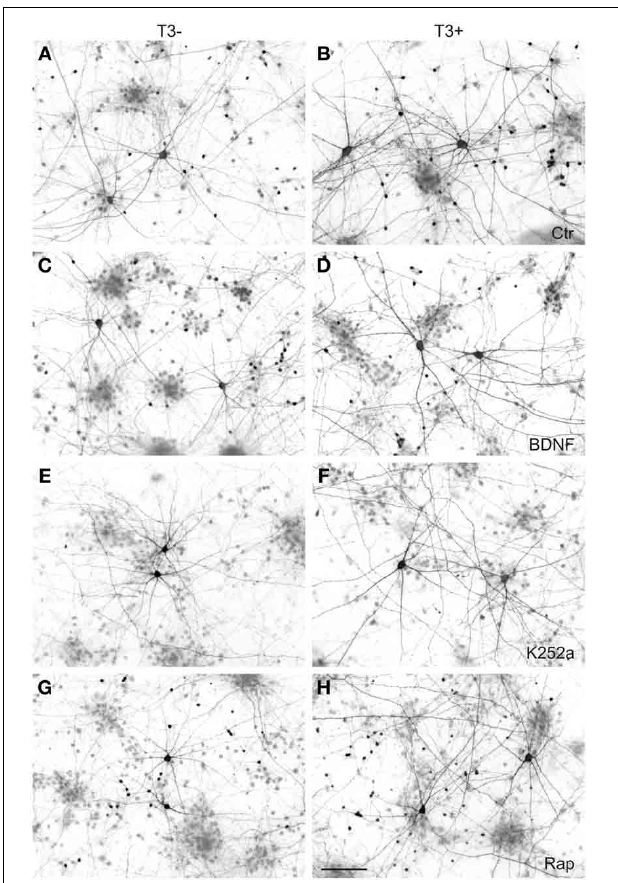
FIGURE 9 | GABAergic neurons in 14-day-old neocortical networks grown with or without T3. GABA immunocytochemistry; T3 − , left; T3 + , right; Ctr, control cultures (A,B) ; BDNF (C,D) ; K252a, cultures treated with the antagonist to block trkB pathway (E,F) ; Rap, cultures treated with the mTOR antagonist rapamycin (G,H) . Scale bar = 100 μ m.